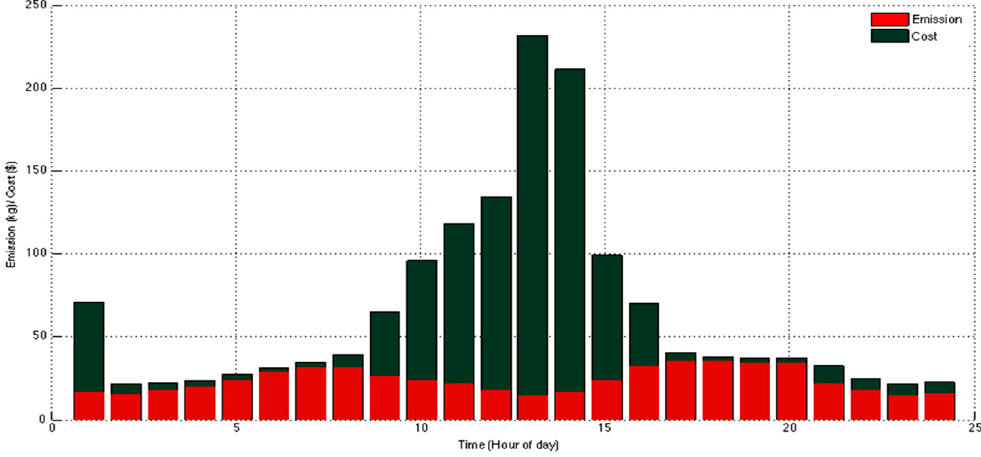
Figure 4. MG operation cost vs. generated emission over 24 h.